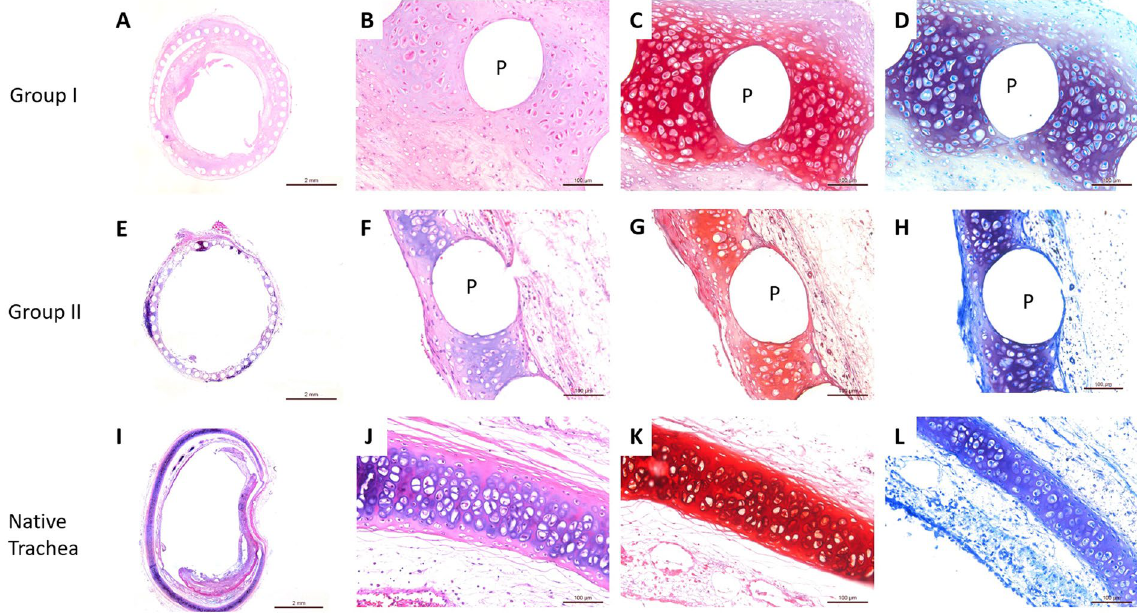
trachea. ( A , B , E , F , I and J ) Histological stainings with H&E. ( C , G and K ) Histological stainings with Safranin O. ( D , H and L ) Histological stainings with Toluidine blue. Scale bars: ( A , E and I ) 2 mm, ( B – D , F – H , and J – L ) 100 μ m. (P: PCL scaffold bars).